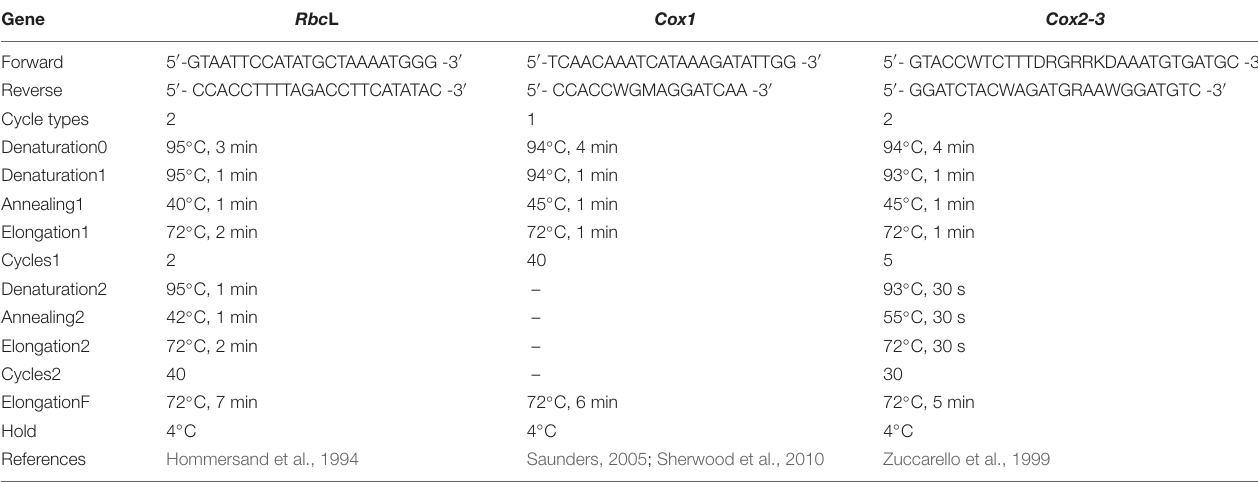
TABLE 2 | Conditions and primers of the Polymerase Chain Reactions (PCRs) associated with each gene. Gene Rbc L Cox1